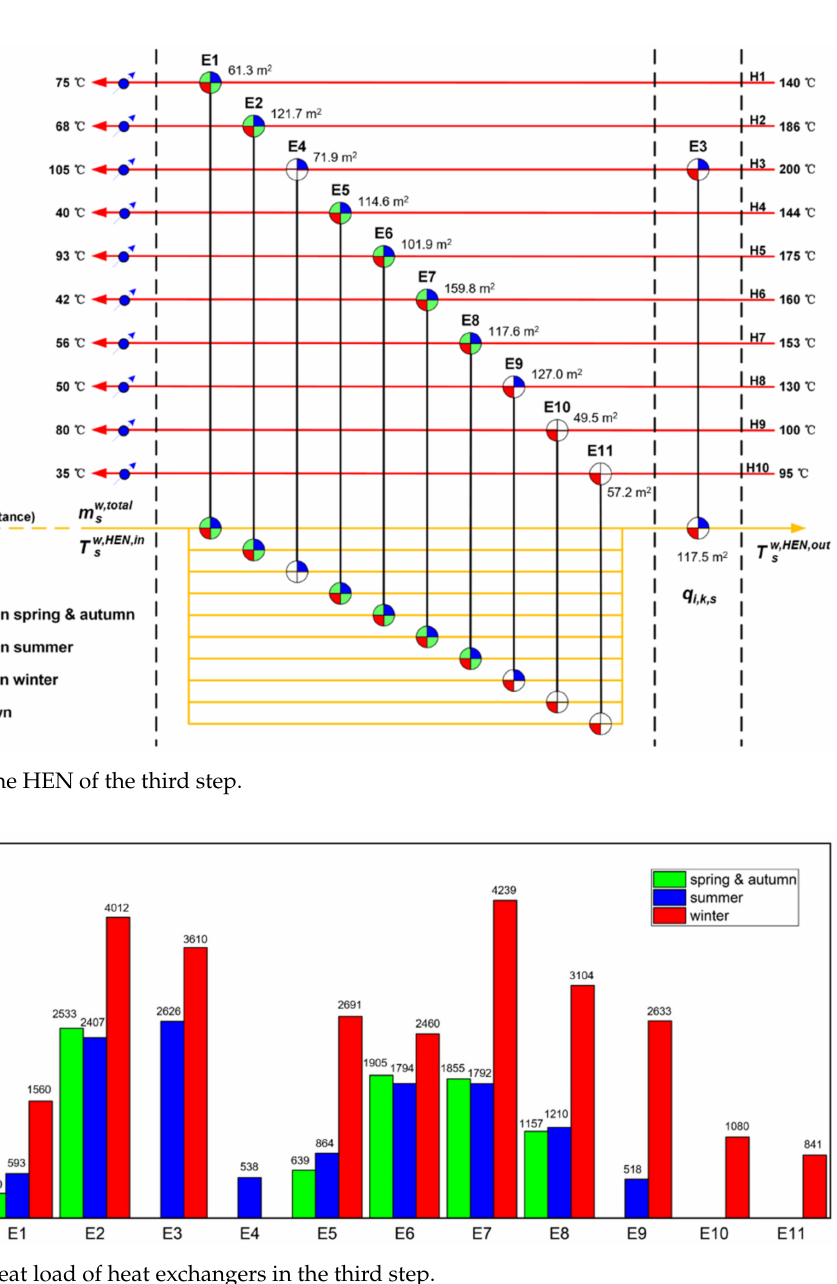
Figure 7. Heat load of heat exchangers in the third step. Table 9. The economic